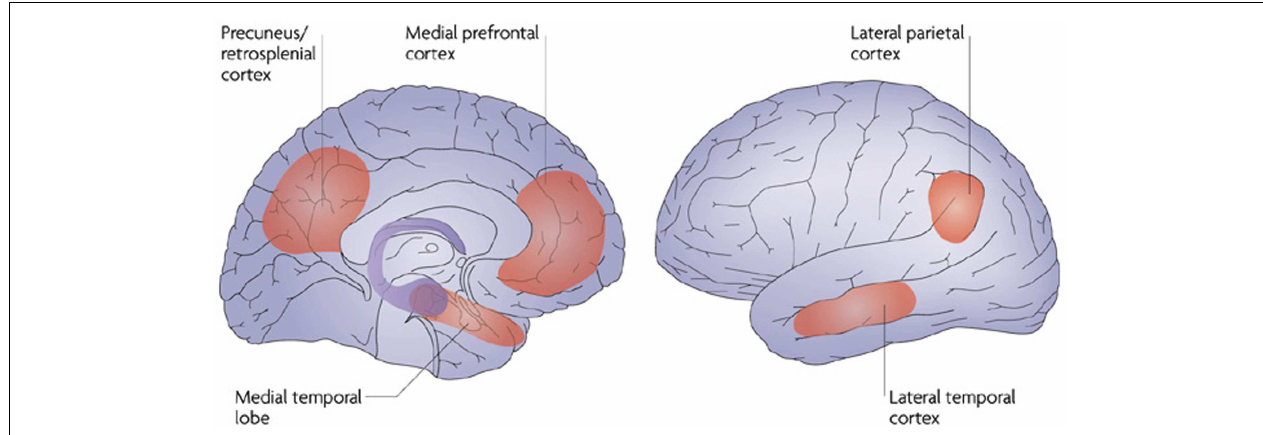
FIGURE 1 | Component structures of the core memory network consistently activated during autobiographical retrieval of the past, and constructive simulation of the future. Notably, the lateral temporal cortex is implicated across past and future contexts, highlighting the central role for semantic memory in past and future oriented thought. Reprinted by permission from Macmillan Publishers Ltd., Schacter et al. (2007). Copyright